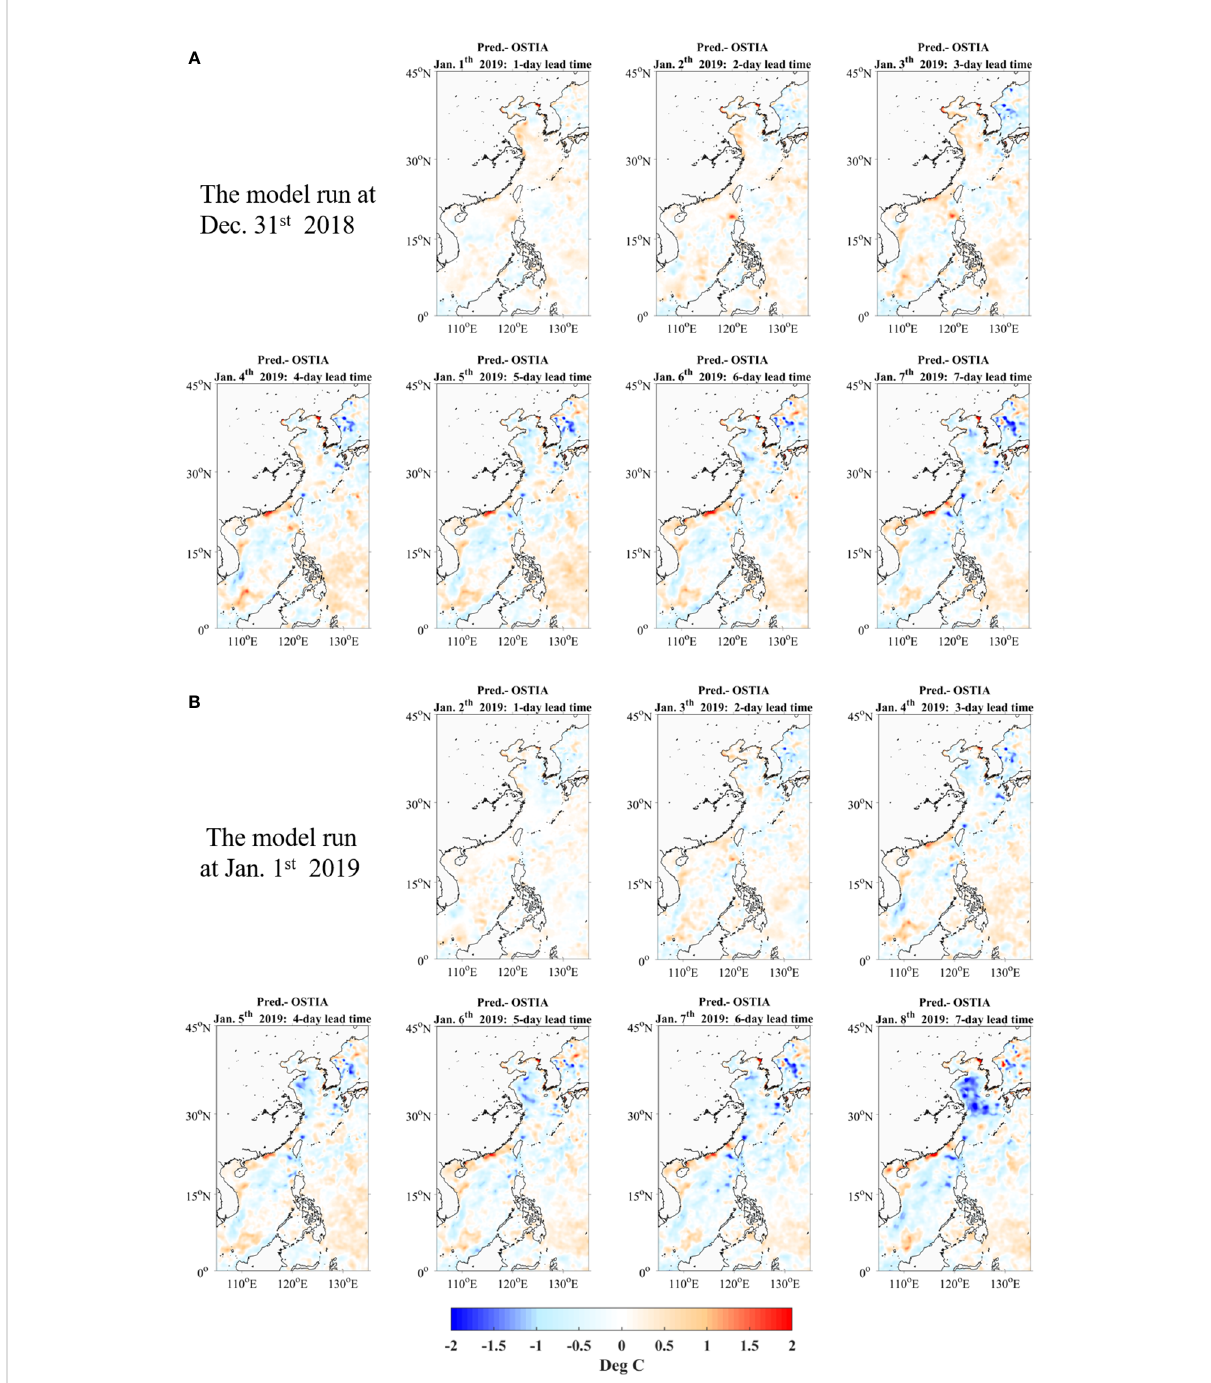
FIGURE 4 The spatial distribution of SST difference between predicted SSTs of the 3DConv-LSTM and OSTIA: (A) the 3DConv-LSTM start date at December 31, 2018; (B) the 3DConv-LSTM start date at January 1,